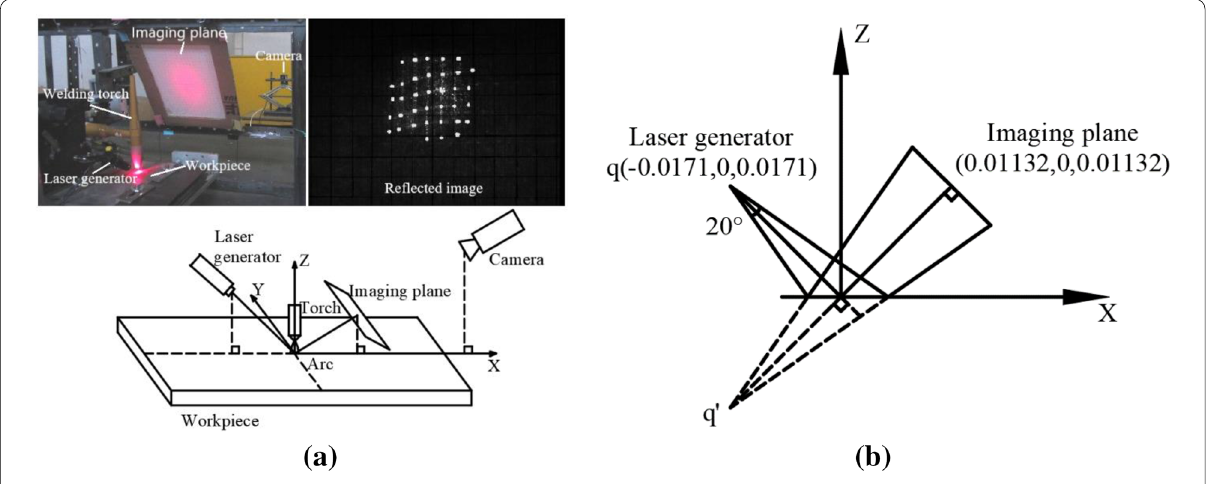
Figure 1 Schematic diagram of test